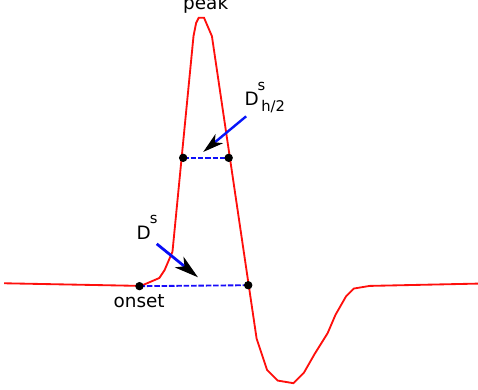
Figure 6. Features related to